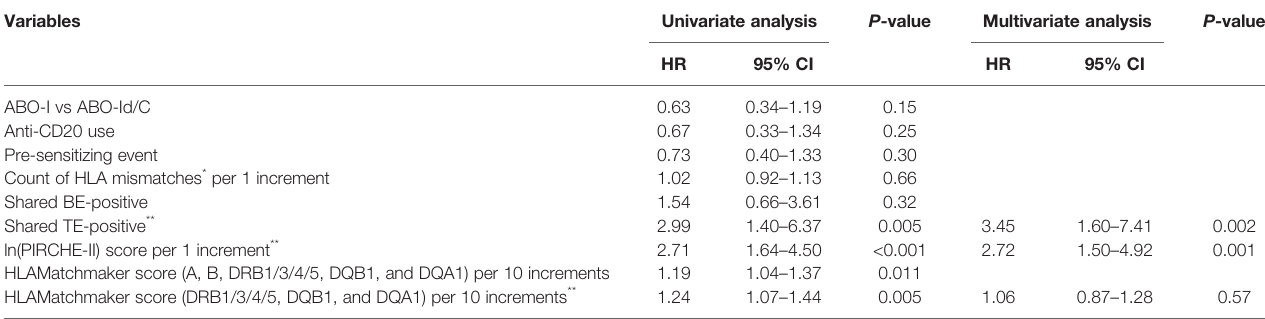
TABLE 4-2 | Cox proportional hazards models of factors associated with dnDSA production in 5 years (n = 50).